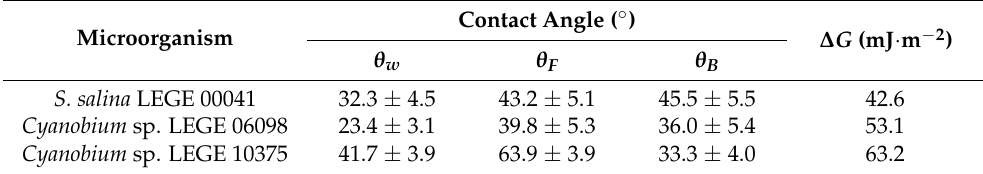
Table 2. The contact angles with water ( θ w ), formamide ( θ F ), and α -bromonaphthalene ( θ B ) and the hydrophobicity ( ∆ G ) for cyanobacterial strains, calculated according to Equation